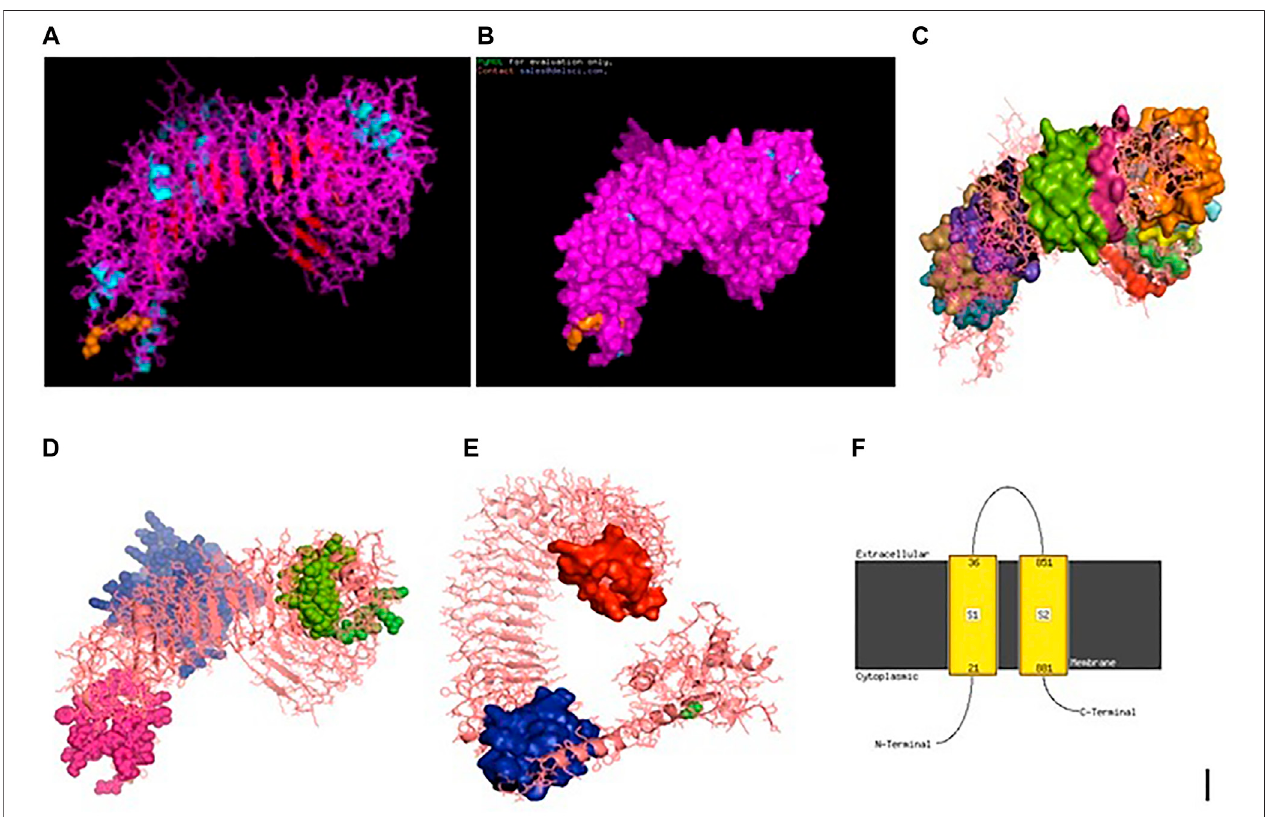
FIGURE3|(A) 3DstructureofTLR7ofindigenousduck. (B) 3DstructureofTLR7ofduck(surfaceview). (C) 3DstructureofTLR7ofduckwiththeLRRregion. (D) 3D structure for TLR7 of duck domains. (E) 3D structure of TLR7 of duck with LRRNT, TPKRC2, and GPI anchor. (F) Transmembrane helix for TLR7 of